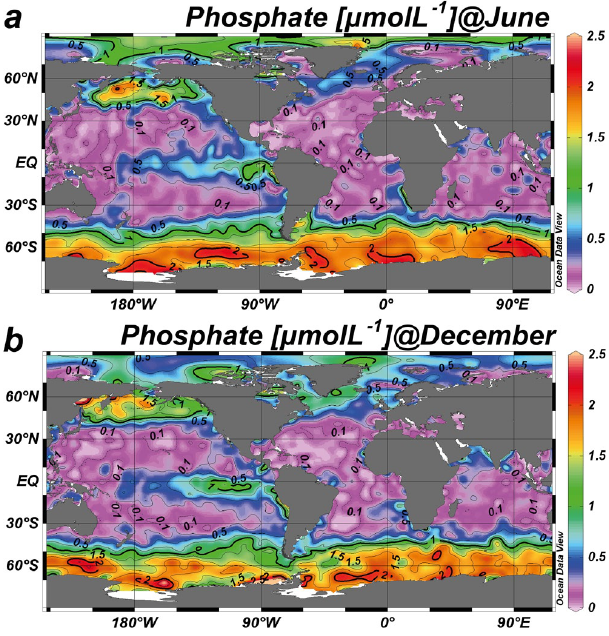
Fig. 1. Phosphate concentrations (unit µmoll − 1 ) at 10m for June (a) and December (b) from WOA09 (data from Garcia et al., 2010).